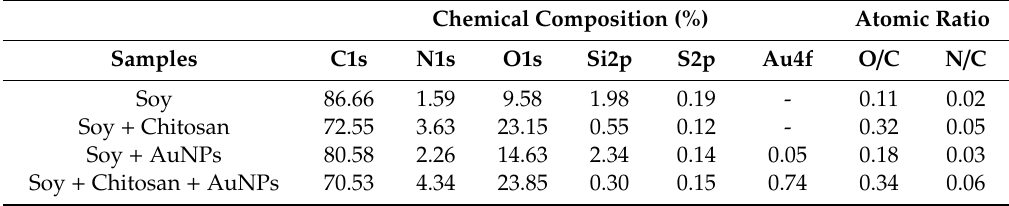
Table 1. Relative chemical composition and atomic ratio of soybean fabric samples coated with chitosan and gold nanoparticles